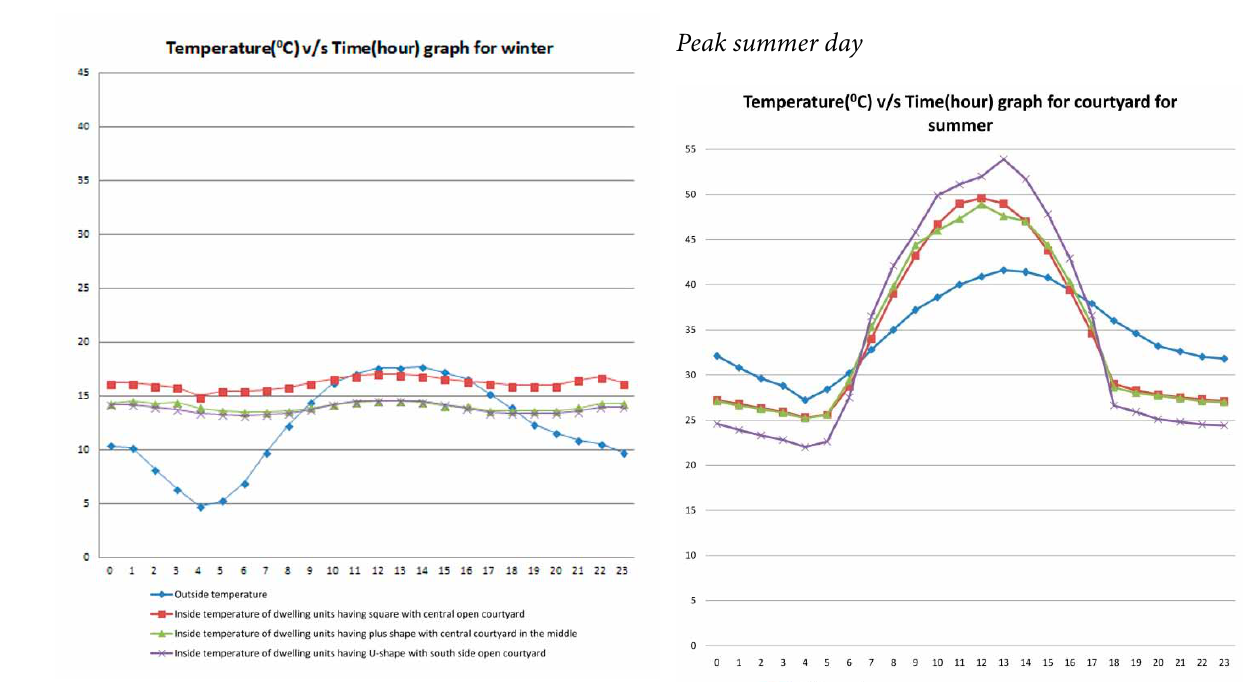
fig. 18. recorded average temperatures in week from 29 th December to 4 th january during coldest period of the year respectively